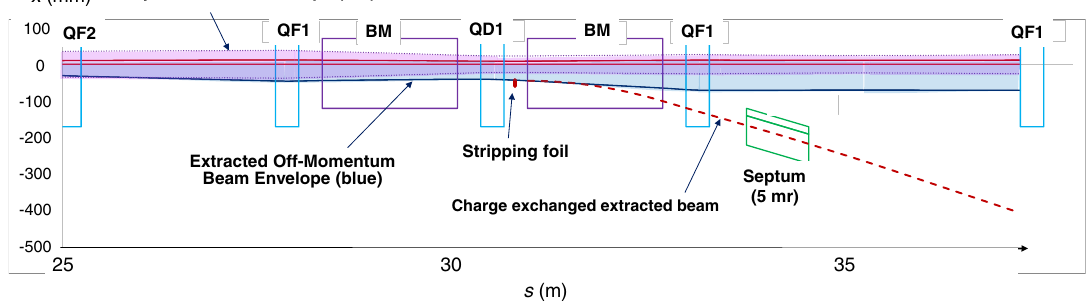
FIG. 7. Beam envelope and beam centroid in energy sweep